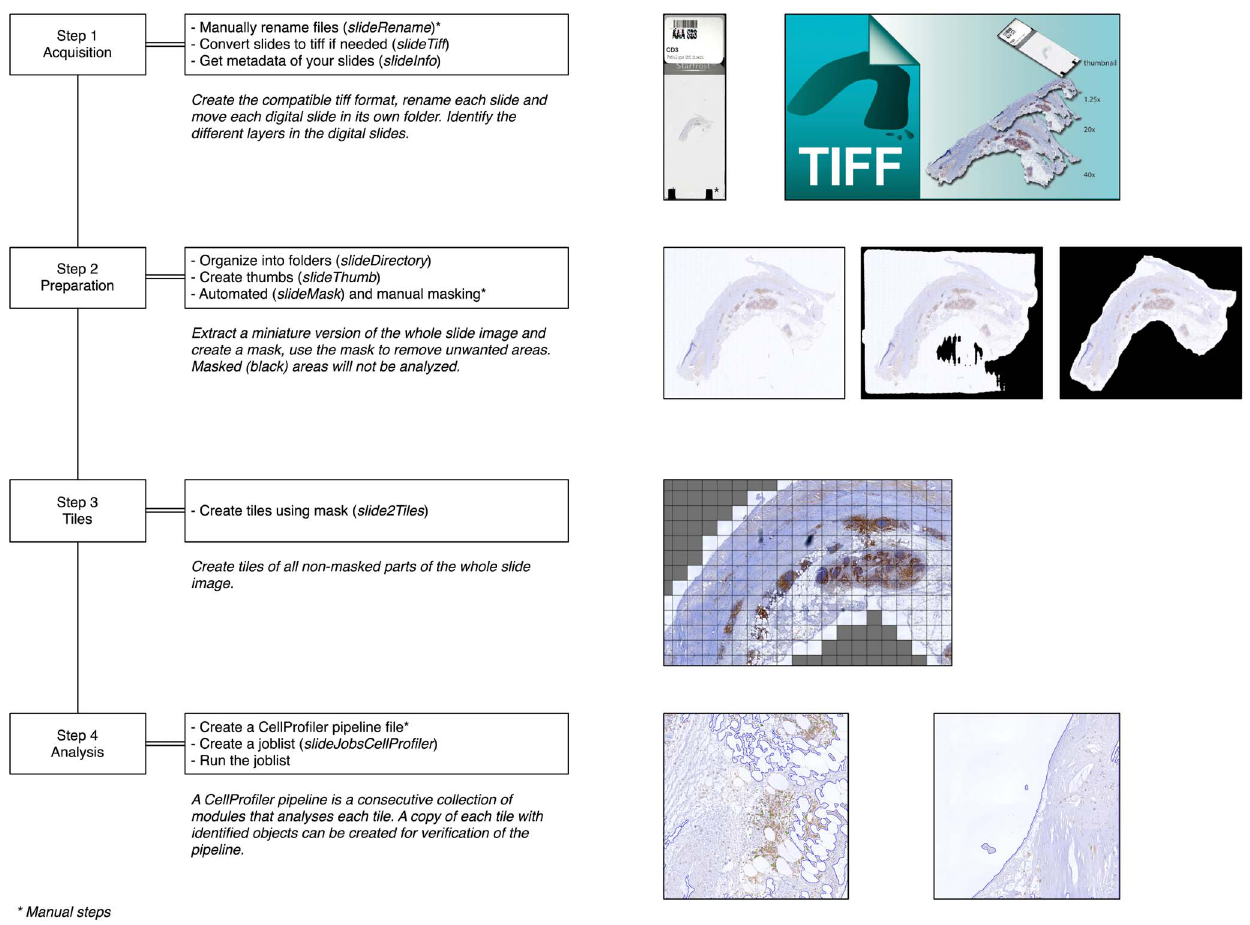
Figure 1. The four step slideToolkit workflow. An overview of the slideToolkit workflow with a summary and illustration for each step.